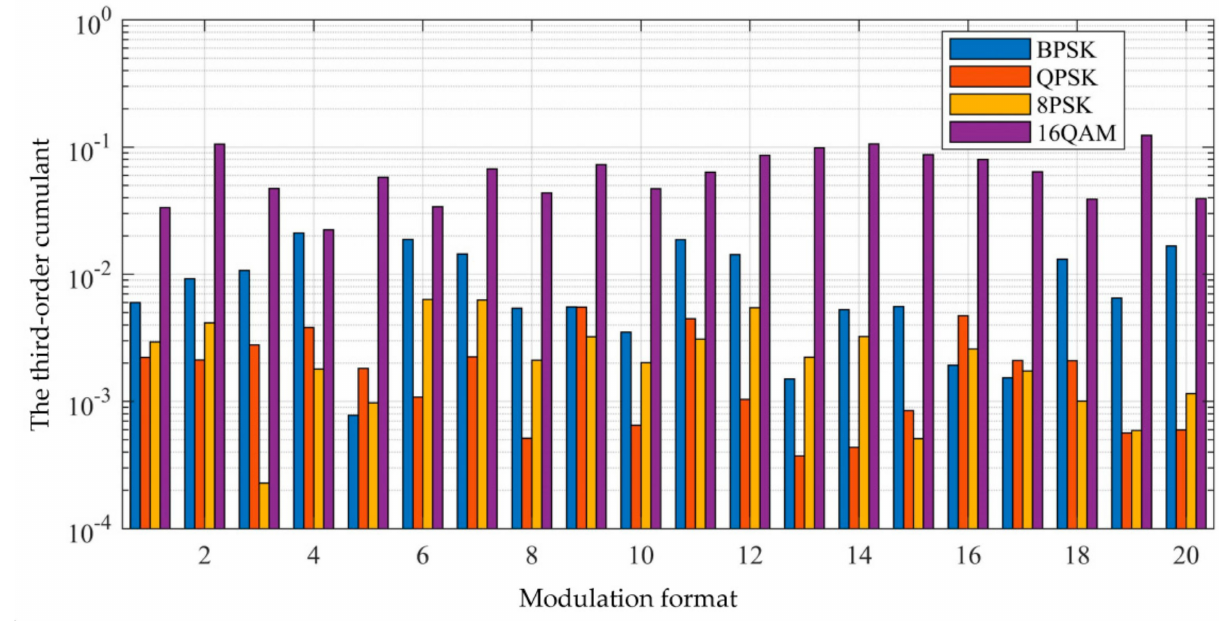
Figure 1. Comparison of third-order cumulant of imaginary parts of OFDM